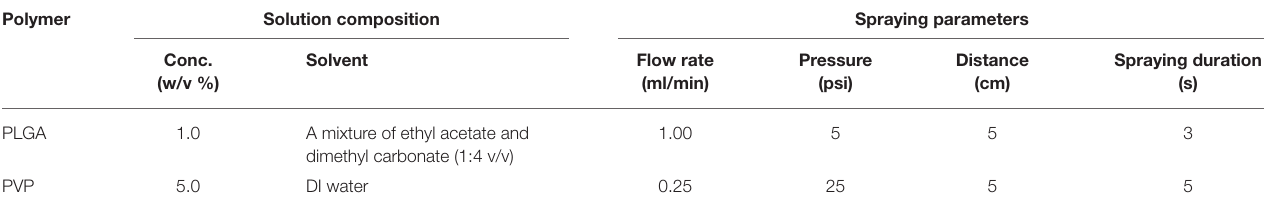
TABLE 1 | Summary of solution compositions and spraying parameters. Polymer Solution composition Spraying